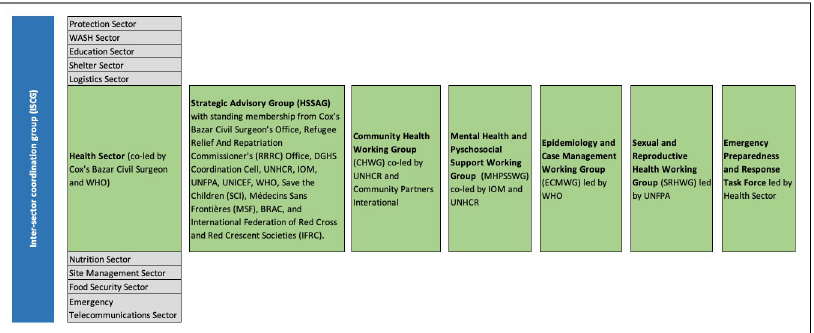
Fig 1. Coordination structure of humanitarian stakeholders with details of health sector coordination